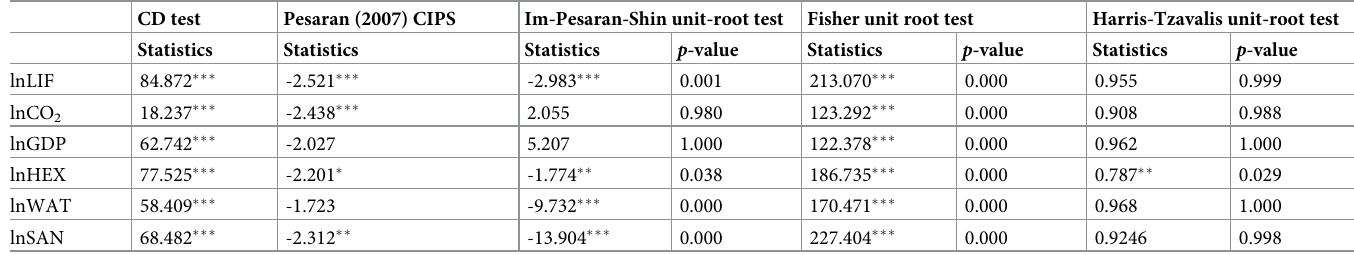
Table 2. The results of cross-sectional dependence and stationary